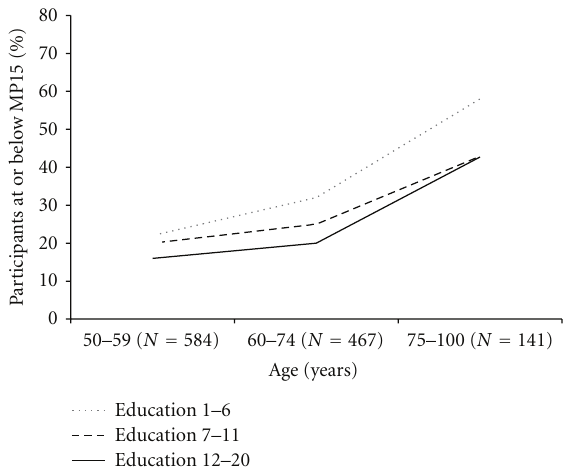
Figure 4: Percent of participants at or below the MP15 (the 15th percentile of the MoCA-ChLA score in the 50–59 age